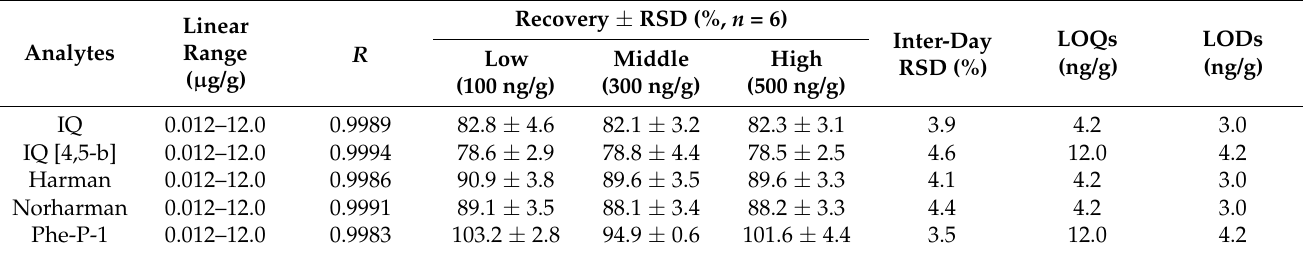
Table 1. Analytical performances of the